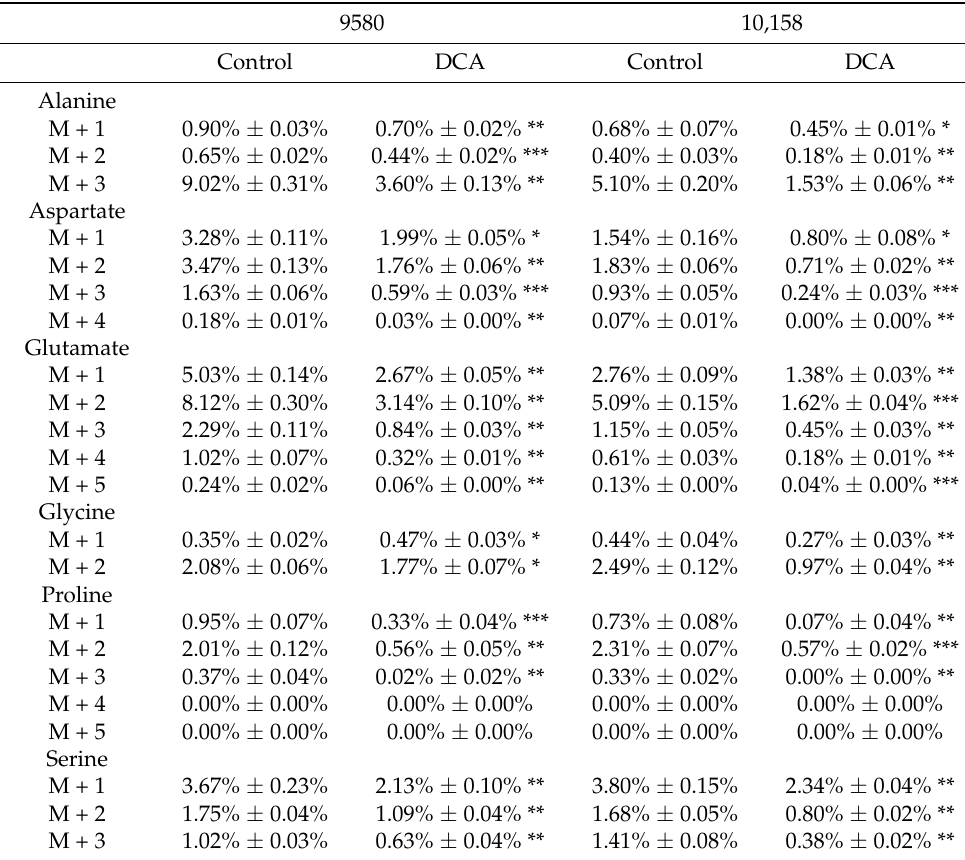
Table 1. Enrichment profiles and percentage of 13 C ‐ enrichment in six selected amino acids in con ‐ trols and after treatment with DCA in 9580 and 10,158 cancer cell lines. * p < 0.05, ** p < 0.01 *** p < 0.0001 compared to controls. Experiments were carried out as triplicates.